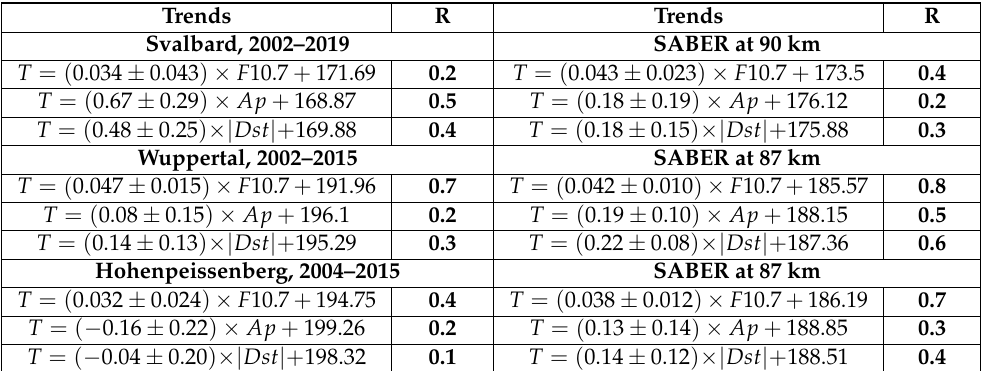
Table 1. Trends with correlation coefficient R obtained from ground-based and SABER temperature measurements from the overlapped time period.